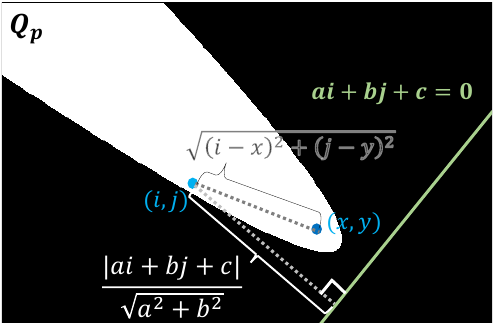
Figure 7. Visualizing result of (11). The white area is the set Q p